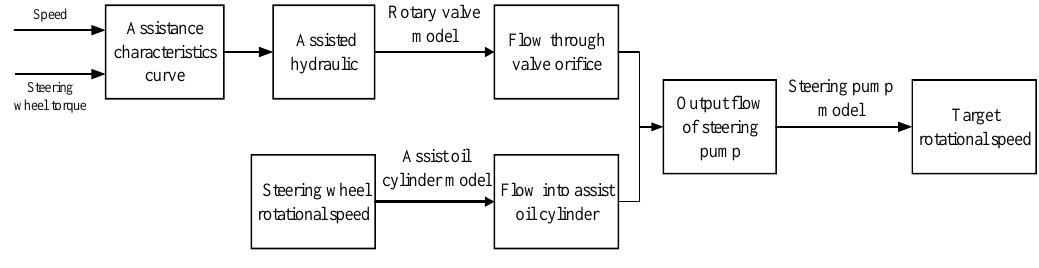
Figure 9. Calculation of PMSC inner rotor target speed.